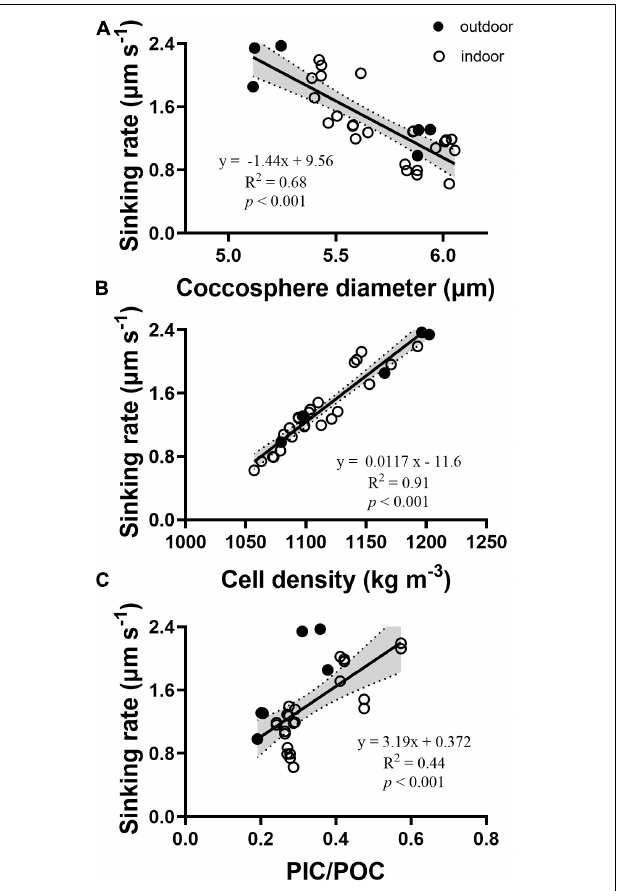
FIGURE 4 | The relationship of sinking rates vs. coccosphere diameter (A) , cell density (B) , and PIC/POC ratios (C) of Gephyrocapsa oceanica . The solid line was obtained by linear fitting. Data represent sinking rates of the indoor and outdoor grown